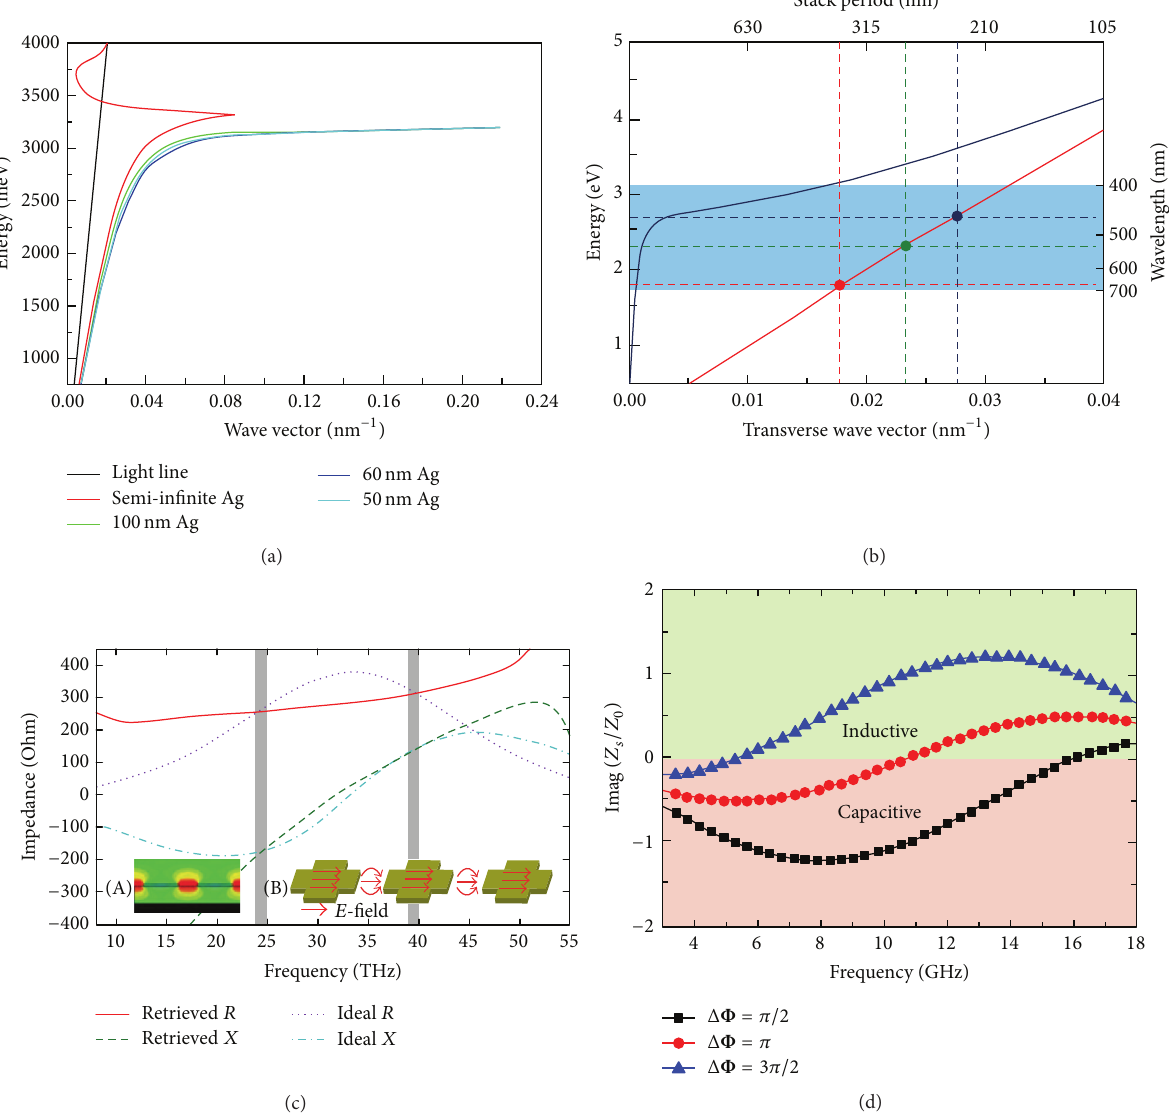
Figure 55: (a) Dispersion of an ultrathin metallic film with ultrasmall effective wavelength. (b) Dispersion of a metasurface consisting of metal-insulator-metal (MIM) structure, which acts as a high efficient color filter. (c) Lorentz dispersion for broadband metasurface absorber. (d) Lorentz-type dispersion for broadband polarization control. Figures are reproduced from (a) [55], (b) [17], (c) [114], and (d) [81].